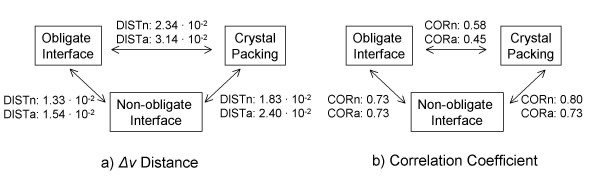
Both Δν distances (a) and correlation coefficients (b) are shown for each pair of interaction types.